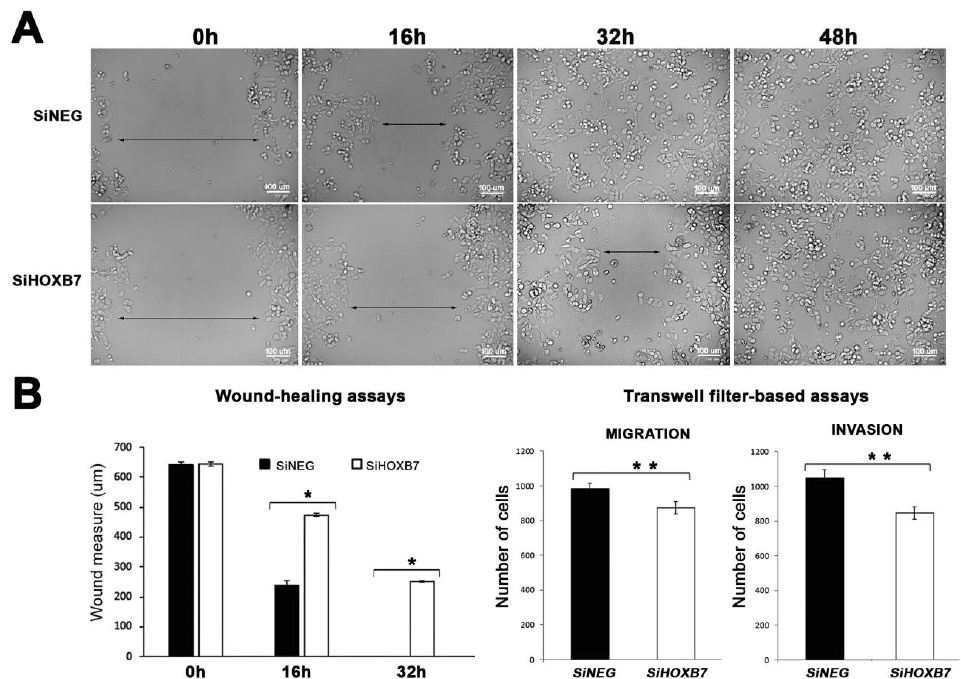
Figure 2. Analyses of cell migration and invasion in MDA-MB-468 cells transfected with siHOXB7 and control siNEG. Wound-healing assays suggest reduced capacity to migrate in HOXB7-silenced cells, detectable after 16h post-transfection ( A ). Transwell filter-based assays also point to lower migration and invasion abilities in HOXB7-silenced cells than in the controls ( B ). Three independent biological replicates were used in the statistical analyses, and significant differences are indicated with asterisks (*, p < 0.001; **, p < 0.05), based on t -test